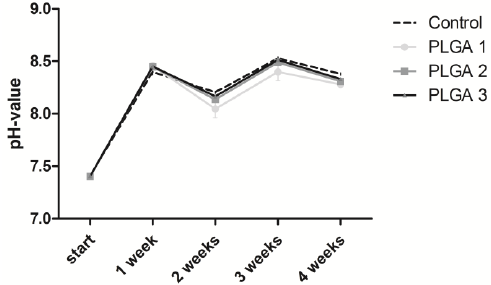
Figure 1. Change of pH values in cell culture media during incubation with PLGA 1-, 2-, and 3-coated coverslips. Slides were incubated in media for one, two, three, and four weeks. The supernatants were used to measure the pH values. An uncoated coverslip served as a control. The analysis was done with two equally coated coverslips of each PLGA and two measurements for each